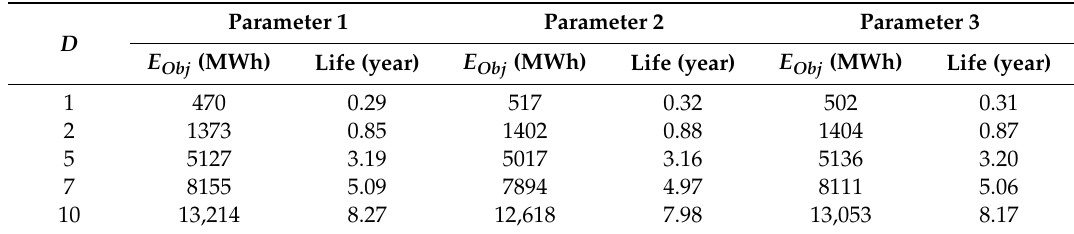
Table 7. Various degradation model parameters for ESS.